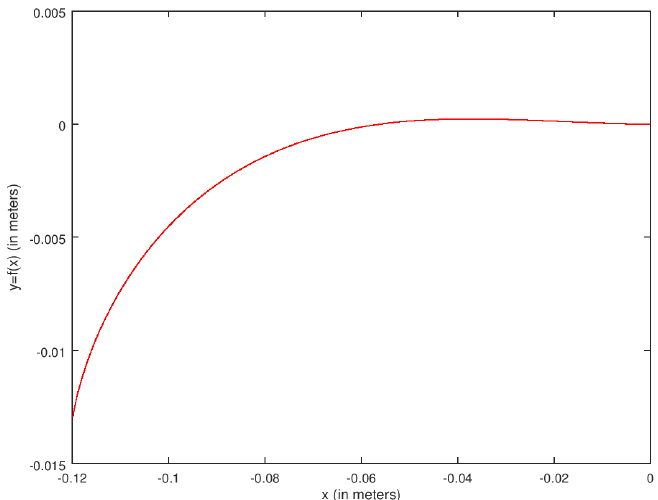
Figure 2. Feasible Vehicle Robot Trajectory (Initial condition=[zeros(7,1);2*ones(7,1)]).